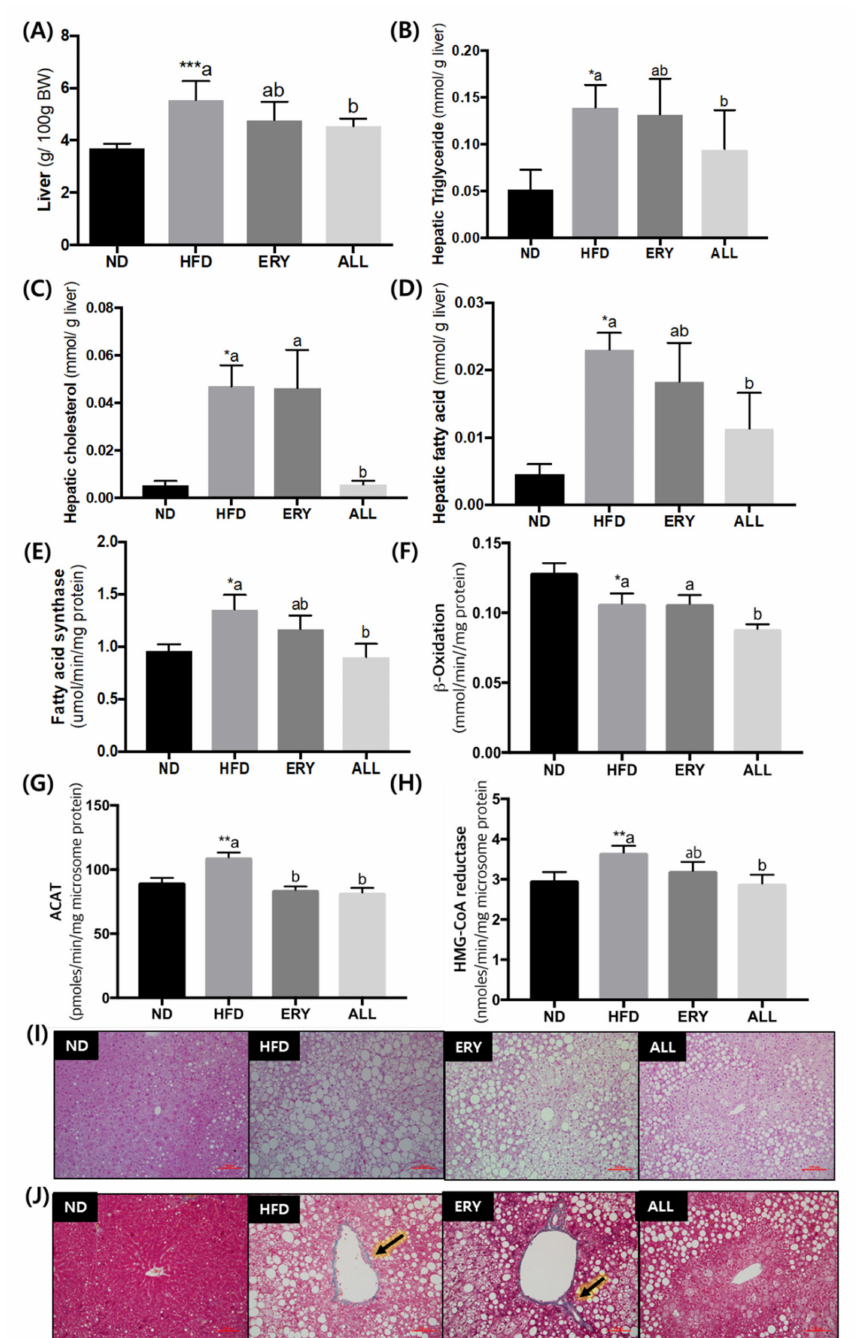
Figure 2. E ff ects of D-allulose supplementation for 16 weeks on; ( A ) Liver weight; ( B – D ) Hepatic lipid profiles; ( E , F ) Enzyme activities related to lipid metabolism; and ( I ) morphology. Data are mean ± SE; ND, normal diet (AIN-76); HFD, high-fat diet (AIN-76, 20% fat, 1% cholesterol); ALL, (HFD + 5% D-allulose). Mean values are significantly di ff erent for ND vs HFD, * p < 0.05, ** p < 0.01, *** p < 0.001; a, b Mean not sharing a common letter are significantly di ff erent among the groups at p < 0.05. (H) L: A ratio, leptin:adiponectin ratio; (I) Hematoxylin and eosin (H&E)-stained transverse section of epididymal fat and liver; Representative photomicrographs of the liver are shown at × 200 magnification; (J) Fibrillar collagens, primarily collagen I and III, are stained blue, as indicated by arrowheads; Representative photomicrographs of the liver are shown at × 200